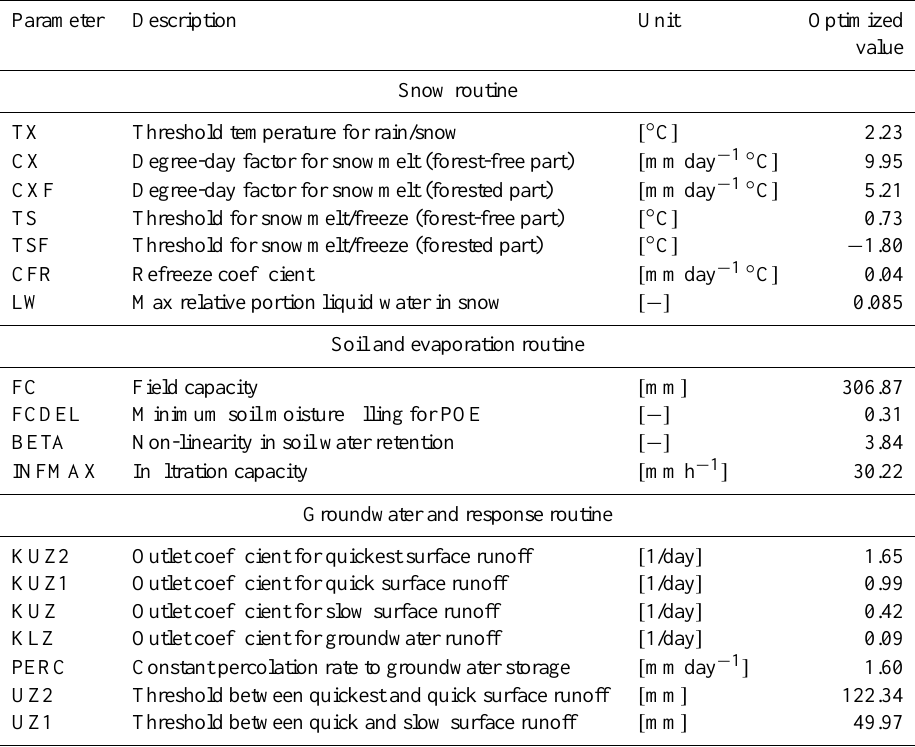
Table 1. Model parameters and corresponding optimized values.